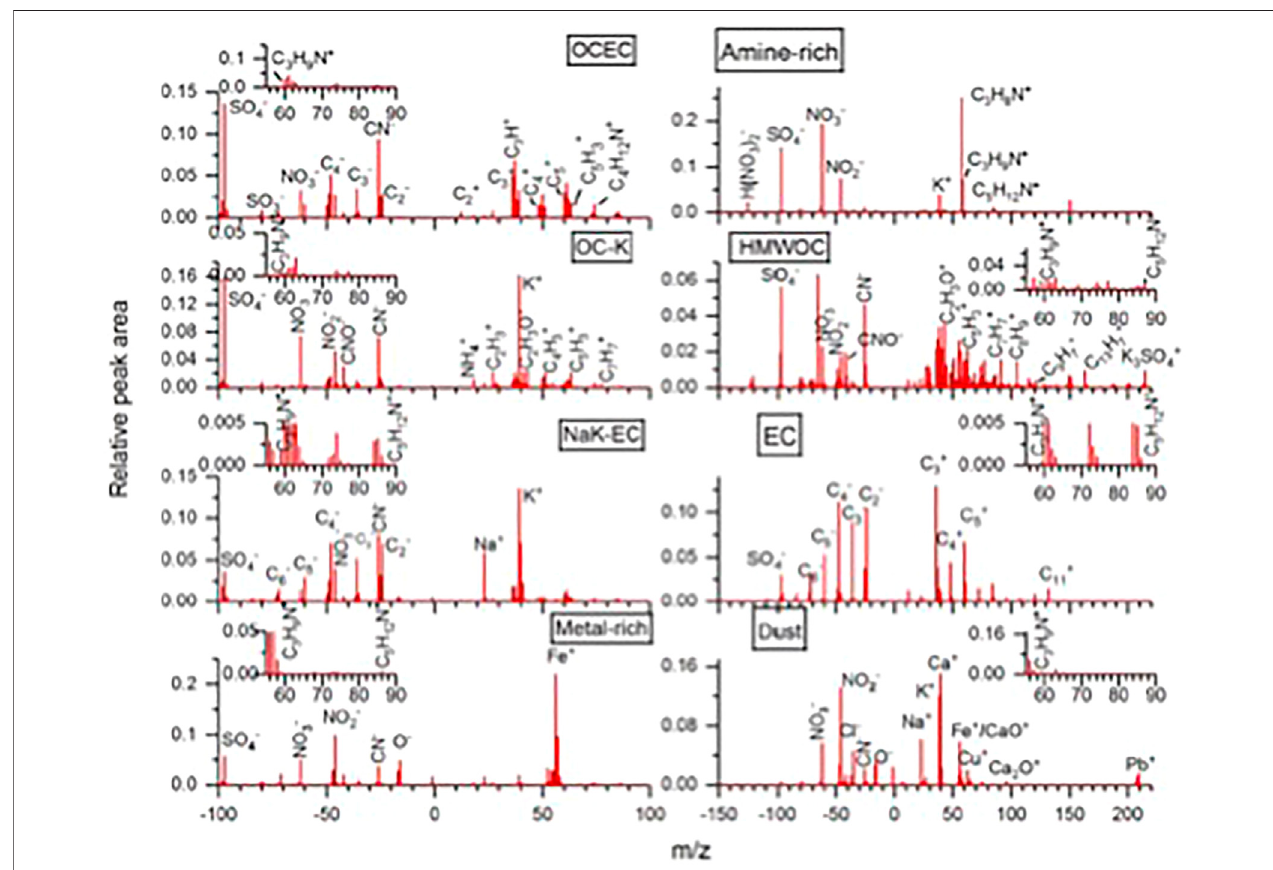
FIGURE 4 | Chemical composition of aerosol particles measured with ATOFMS in urban Guangzhou, China (Lian et al., 2020).